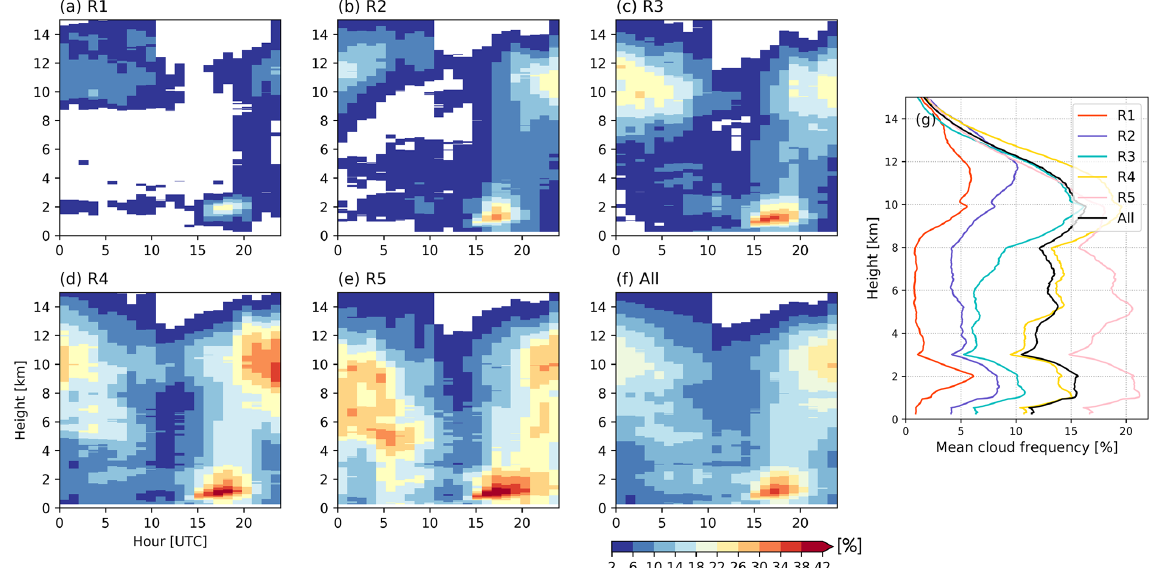
Figure 9. The diurnal cycle of hourly mean cloud frequency (when cloud coverage > 2%) as a function of height for each regime (a–f) according to multi-instrument cloud profiling retrieval. The mean 1h cloud frequency profiles are shown in (g)